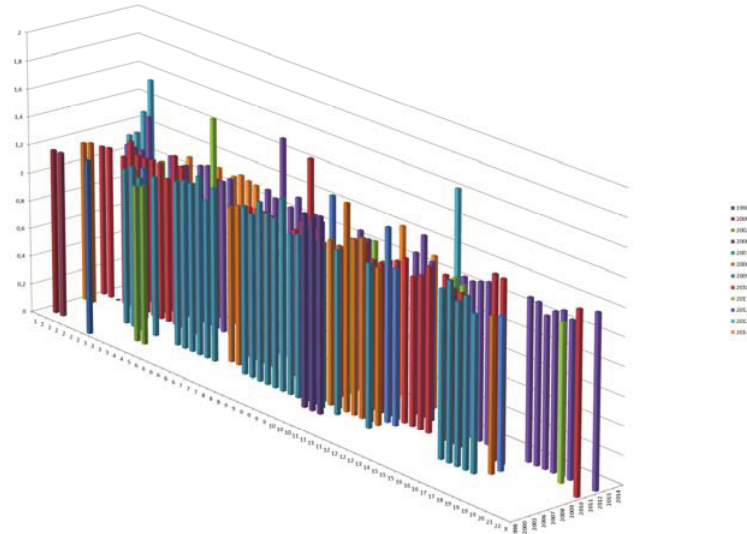
Figure 2. T2D risk variants. X axis shows the chromosomal location, Y shows the effect sizes and Z axis shows the year of discovery. Only 1 risk variant was reported in 1998; there were 2 in 2002, and today, we have a total of ~153 T2D variants.